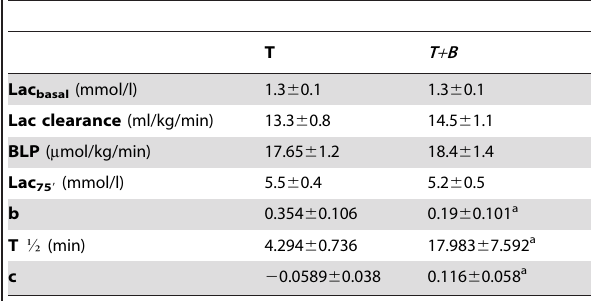
Table 3. Lactate pharmacokinetics.